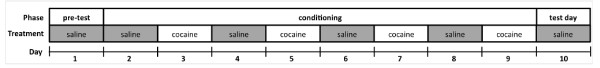
Timeline of the place preference study.